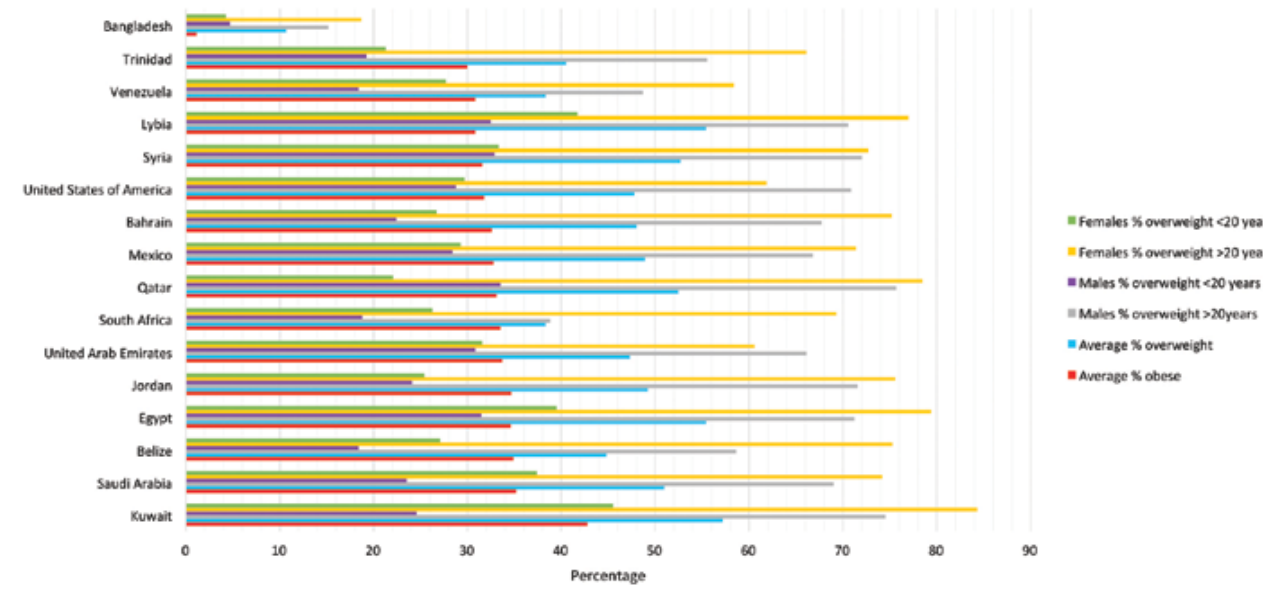
Figure 1. Top 15 “obese